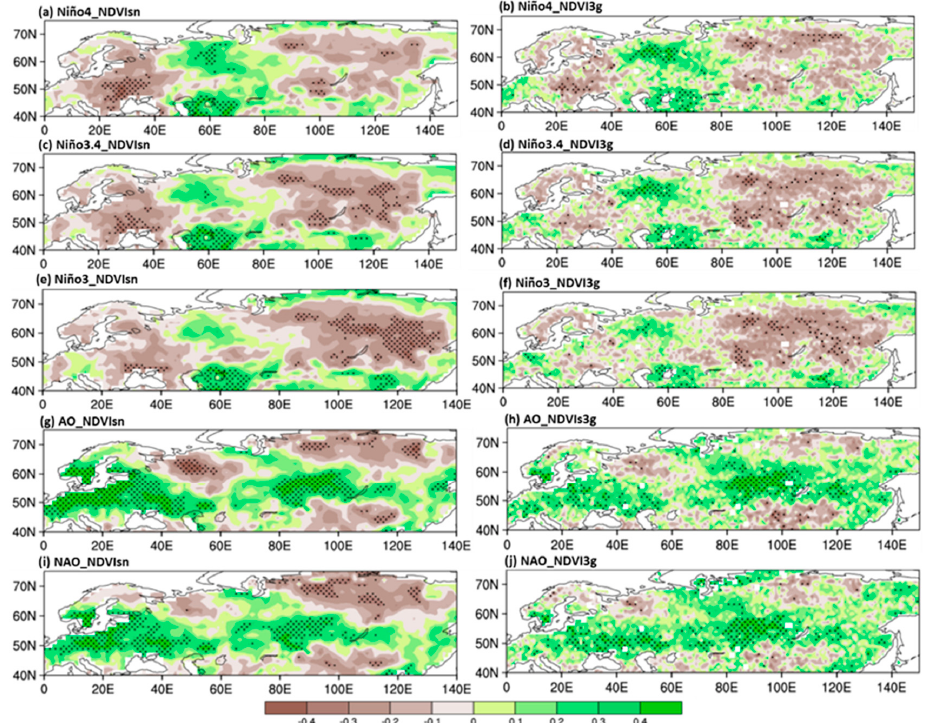
Figure 3. Spatial patterns of correlation coefficients between spring NDVI and winter climate indices over Eurasia: ( a ) NDVIsn and Niño4; ( b ) NDVI3g and Niño4; ( c ) NDVIsn and Niño3.4; ( d ) NDVI3g and Niño3.4; ( e ) NDVIsn and Niño3; ( f ) NDVI3g and Niño3; ( g ) NDVIsn and AO; ( h ) NDVI3g and AO; ( i ) NDVIsn and NAO, and ( j ) NDVI3g and NAO. Dotting areas have the correlation coefficient being statistically significant at the 0.1 level (i.e., p < 0.1) estimated by a local Student’s t -test.